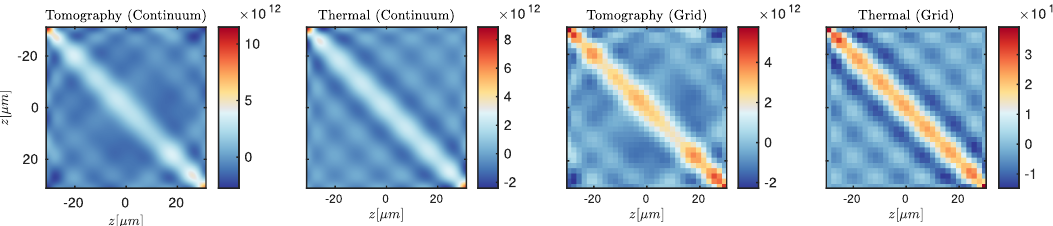
Figure 10: Comparison of the reconstructed initial second moments of the density with the theoretical predictions for a thermal state (at estimated parameter values J = 0.5Hz and T = 60nK). The density plots show the correlations in coordinate space in the entire system (length L = 60 µ m). The reconstructed correlations agree quite well with the theoretical ones. The first two plots show an approximation of the continuum limit correlations corresponding to a very fine discretization and computing the respective eigen-modes of the TLL model, while the second two show a discrete grid of points corresponding to the experimentally measured data, i.e., a coarse-grained representation of the correlations with pixel size ∼ 2 µ m. We find that the transformation of the reconstructed eigen-mode correlations to real space yields a reliable comparison around the diagonal. The off-diagonal features can be directly linked to the presence of a maximum mode cut-off and hence do not represent true correlations in the